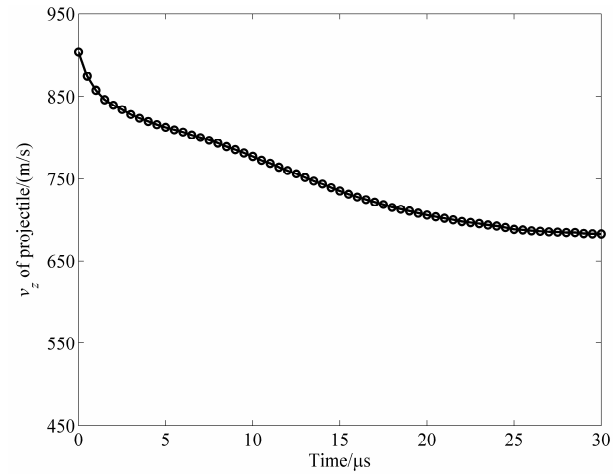
Figure 16. Velocity history of the projectile.